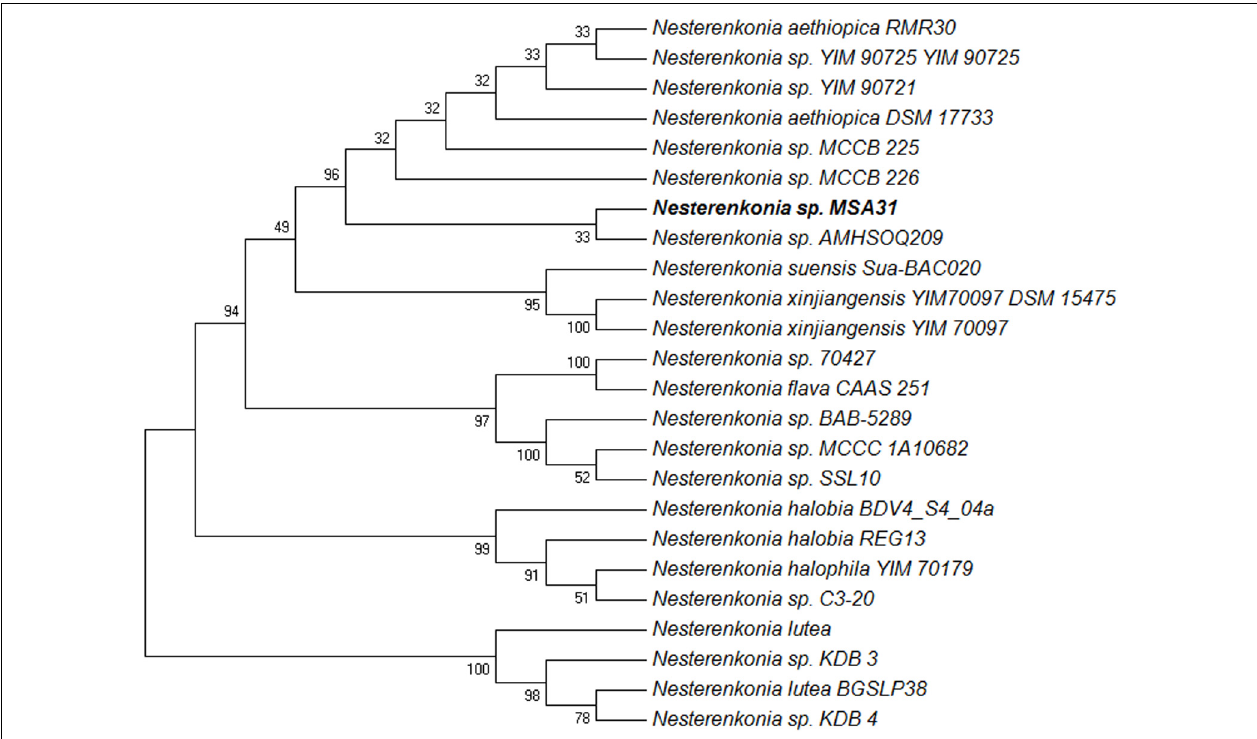
FIGURE 1 | Phylogenetic tree of MSA31 showing representatives of Nesterenkonia sp. The evolutionary history was inferred using the Maximum Parsimony method. Tree #1 out of 9 most parsimonious trees (length = 89) is shown. The consistency index is (0.821429), the retention index is (0.938272), and the composite index is 0.780136 (0.770723) for all sites and parsimony-informative sites (in parentheses). The percentage of replicate trees in which the associated taxa clustered together in the bootstrap test (1000 replicates) are shown next to the